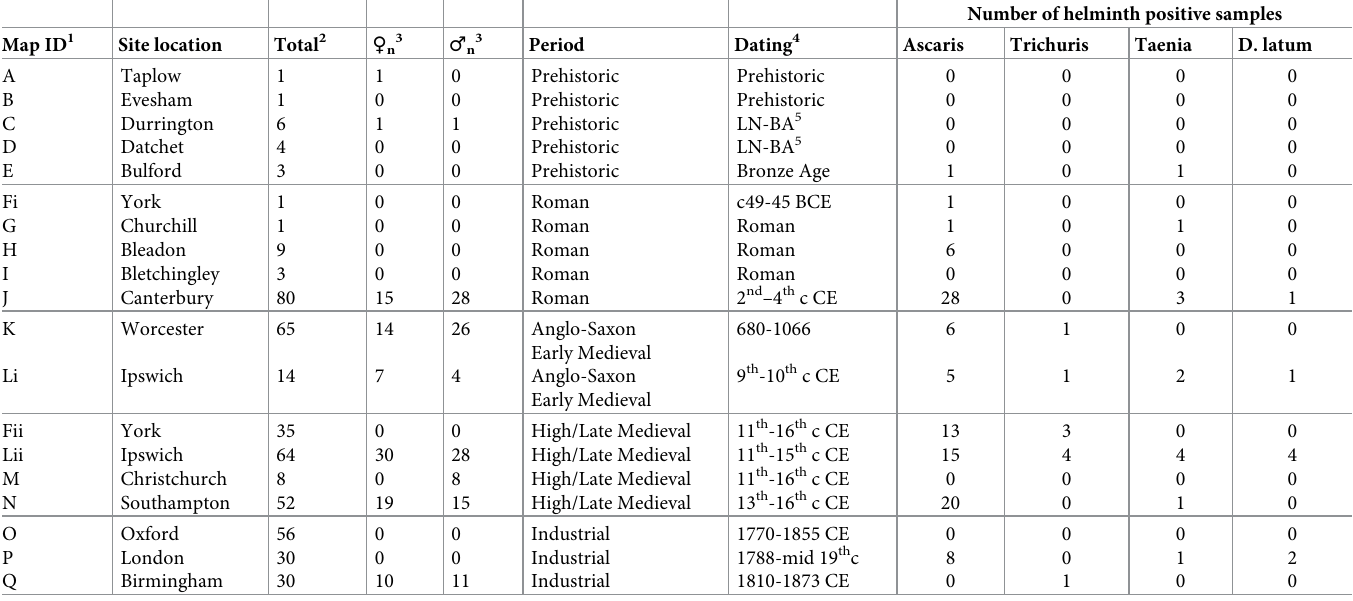
Table 1. Key information on the sampled sites and the numbers positive for helminth